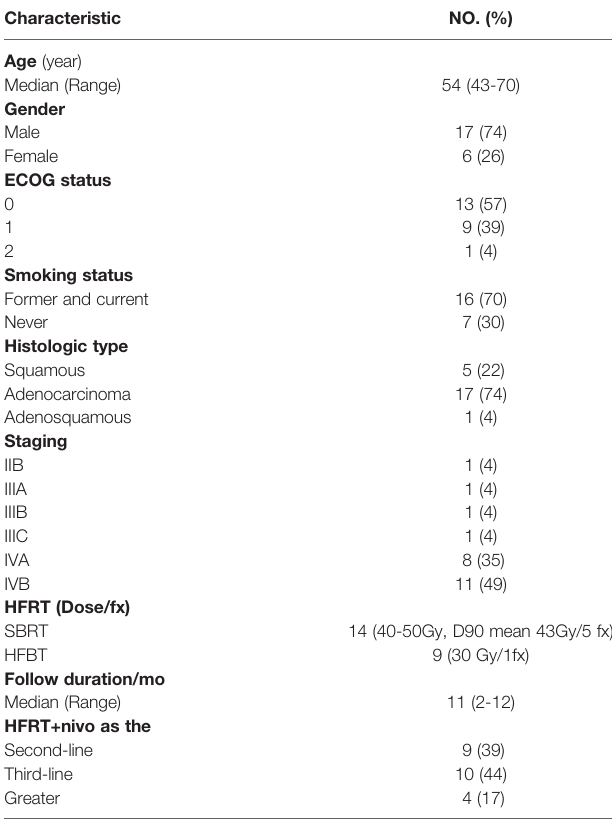
TABLE 1 | Baseline characteristics of patients.